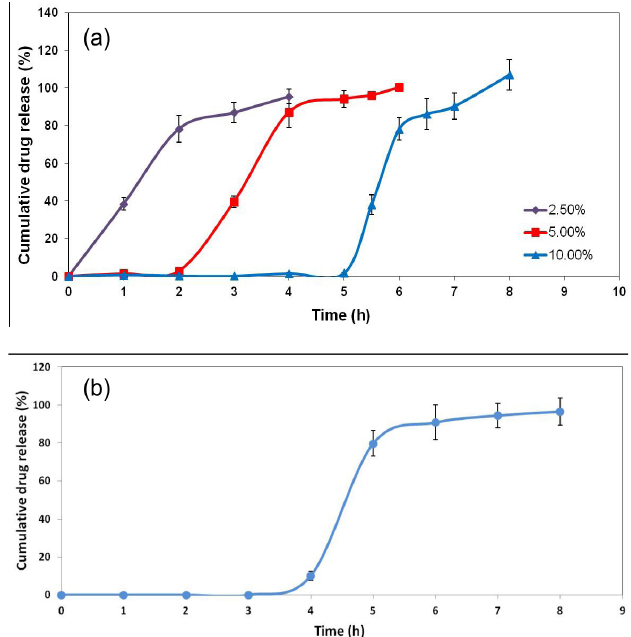
FIGURE 5 – (a) Effect of percent coating weight gain of ethyl cellulose on time lag and in-vitro release profile (b) Dissolution of optimized formulation in sequential buffer